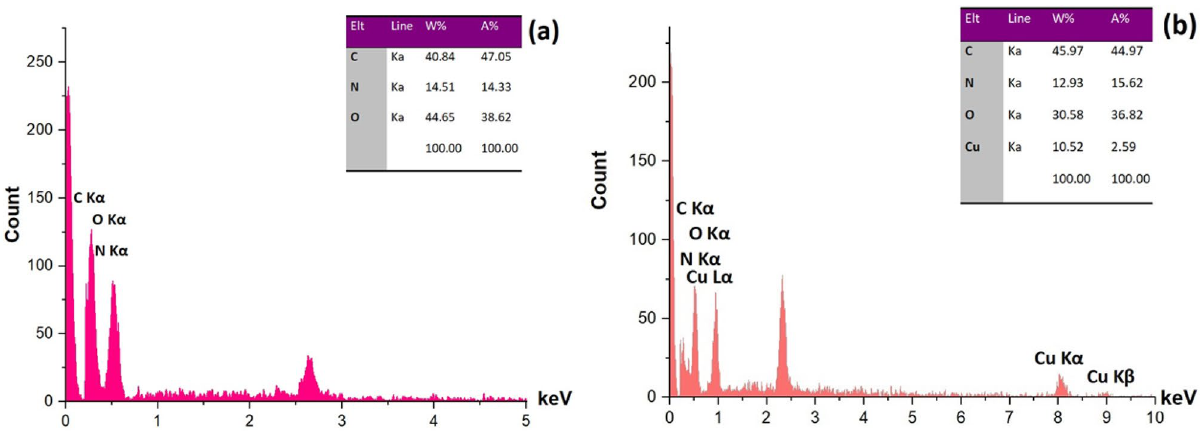
Figure 3. EDAX analysis of ( a ) β-CD-Met and ( b ) Cu@Met-β ‐